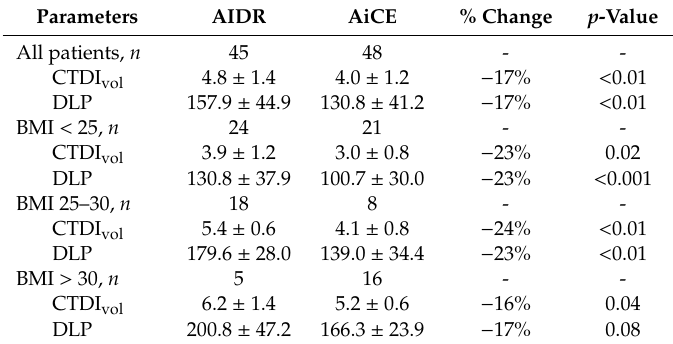
Table 4. Comparison of radiation dose between hybrid-IR (AIDR 3D) and DLR (AiCE). Parameters AIDR AiCE % Change p -Value All patients,